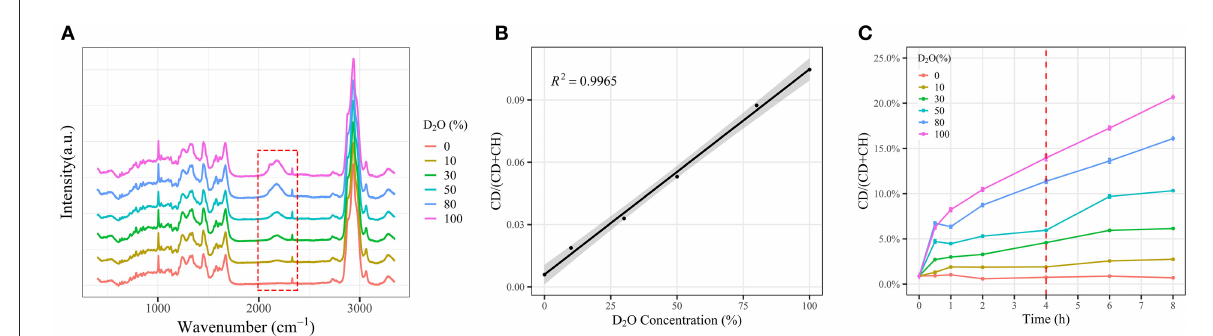
FIGURE3 Effect of deuteroxide on cellular deuterium incorporation measured by Raman spectroscopy. E. coli cells were washed two times with Milli-Q water and cultured in LB broth with different percentages of D 2 O for various time periods prior to acquiring single-cell Raman spectra. (A) Single-cell Raman spectra of E. coli grown to stationary phase in LB media amended with 0, 10, 30, 50, and 100% D 2 O ( n > 50). (B) Regression lines of C-D ratios from E. coli cells with respect to D 2 O percentages ( n > 50). Mean C-D ratios (points) and 95% confidence intervals (light shade) are depicted. (C) Time- and dose-dependent CD ratios of E. coli in response to different percentages of D 2 O, respectively. Mean (solid lines) and standard error (shaded regions) from 50 individual cells are depicted with a 95% confidence